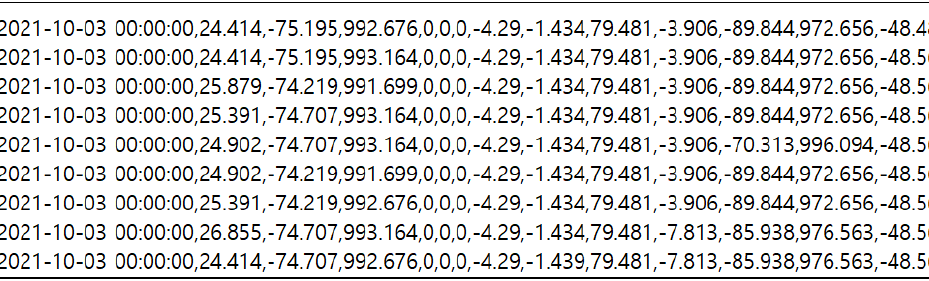
Figure 5. Sample data collected from the acceleration sensor.